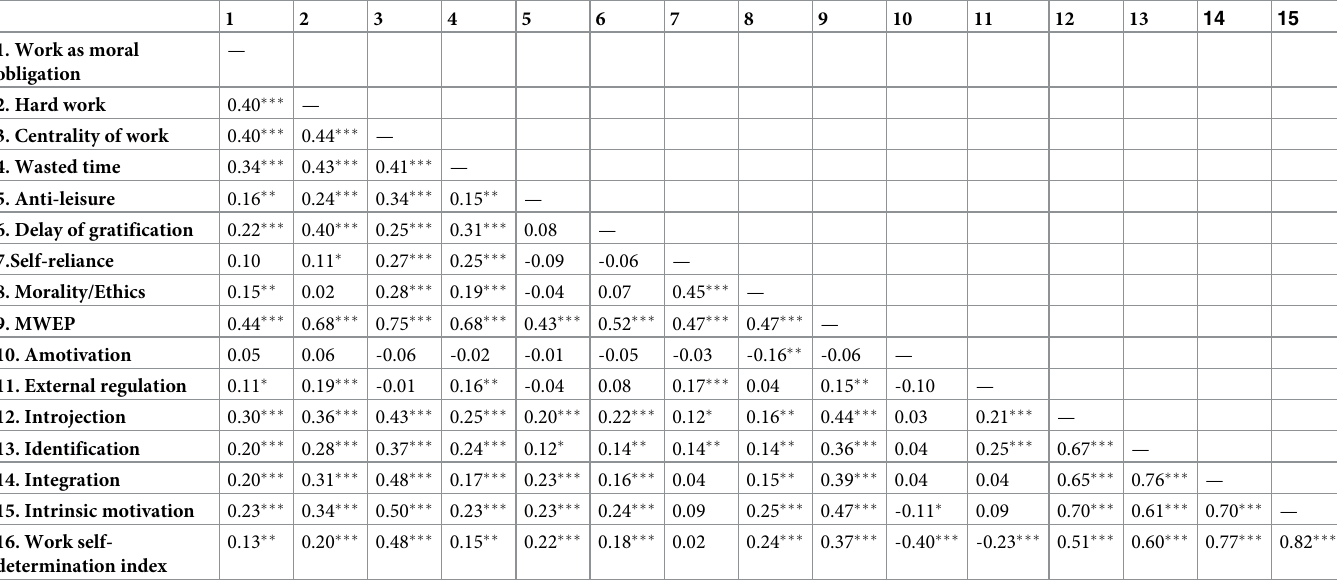
Table 2. Correlations between dimensions of work ethic and components of motivation to